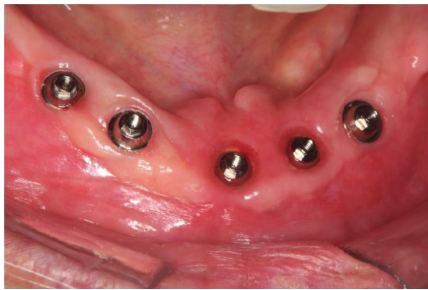
Figure 7: Prosthetic abutments and peri-implant tissue after the 15th day.